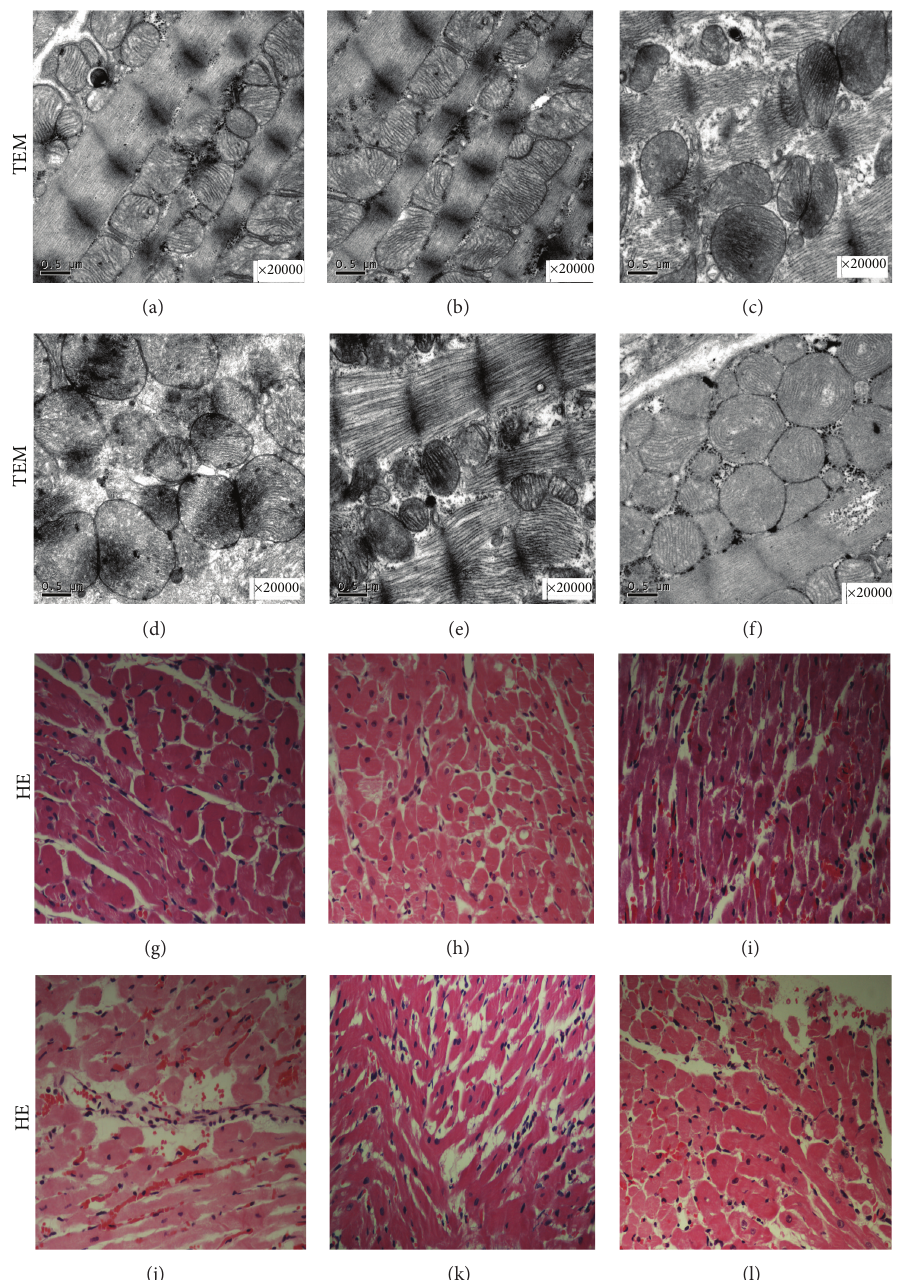
Figure 3: Transmission electron microscopy ((a)–(f)) and histological study ((g)–(l), He × 400) of cardiac tissues from rats of different groups at T 2 time point. (a) Group C 1 and (b) group C 2 : regular myocardial myofilament arrangement, clear intercalated disk structure, normal mitochondrial morphology, and structure with endoplasmic reticulum embedded in myofilament matrix; (c) group I/R 1 and (d) group I/R 2 : disordered arrangement of myofilament, a large number of myofilament fractured, intercalated disk structure unclear, and abnormal mitochondrial morphology (a high degree of swelling, membrane lysis, fuzzy ridge structure, formation of vacuoles, and endoplasmic reticulum vacuolization); (e) group LX 1 and (f) group LX 2 : myofilament arrangement is a little sparse, the intercalated disk structure is slightly fuzzy, and slightly swollen mitochondria; (g) group C 1 and (h) group C 2 : normal size cardiomyocyte, no hemorrhage, or neutrophil granulocyte infiltration; (i) group I/R 1 and (j) group I/R 2 : Cardiomyocyte degeneration, hemorrhage, edema, and significant interstitial neutrophil granulocyte infiltration; (k) group LX 1 and (l) group LX 2 : no significant cardiomyocyte degeneration, no obvious bleeding, slight edema between the myocardial fibers, and mild neutrophil granulocyte